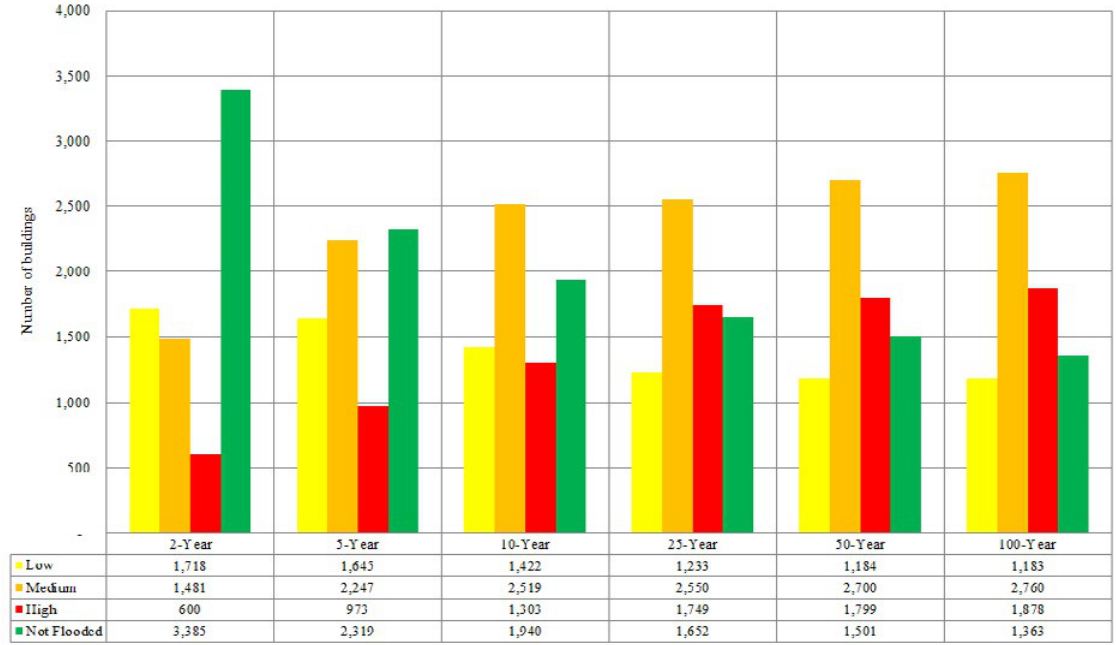
Fig. 12: Number of flooded buildings per hazard level per return period